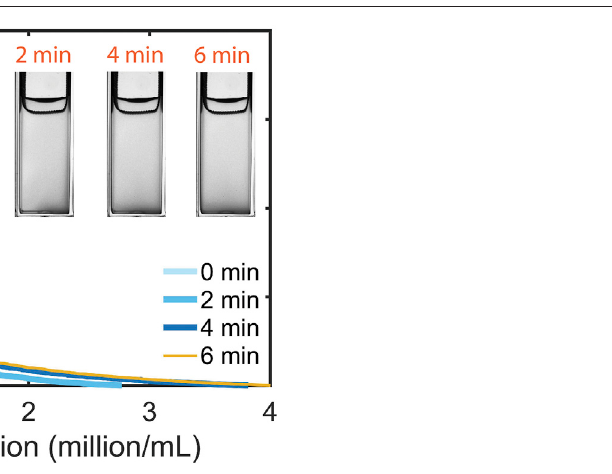
Frontiers in Physics |